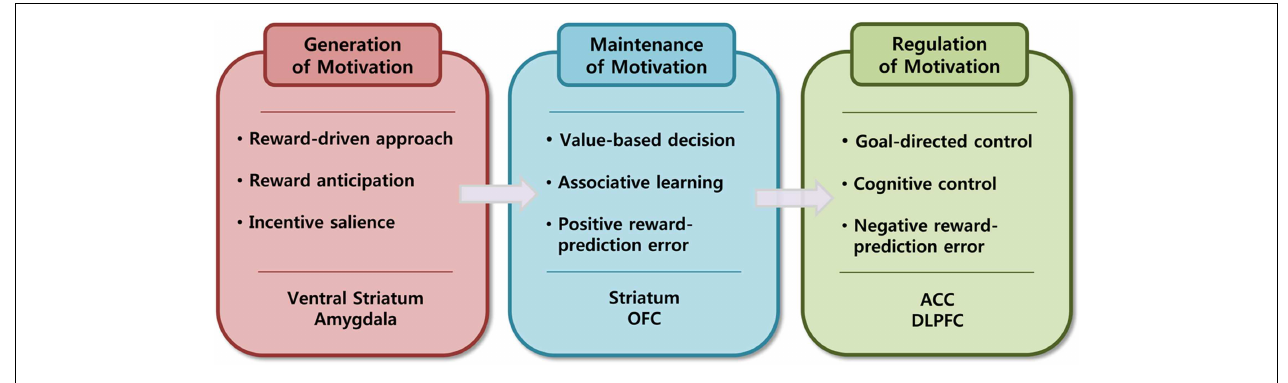
FIGURE 2 |Three sub proceses of motivational